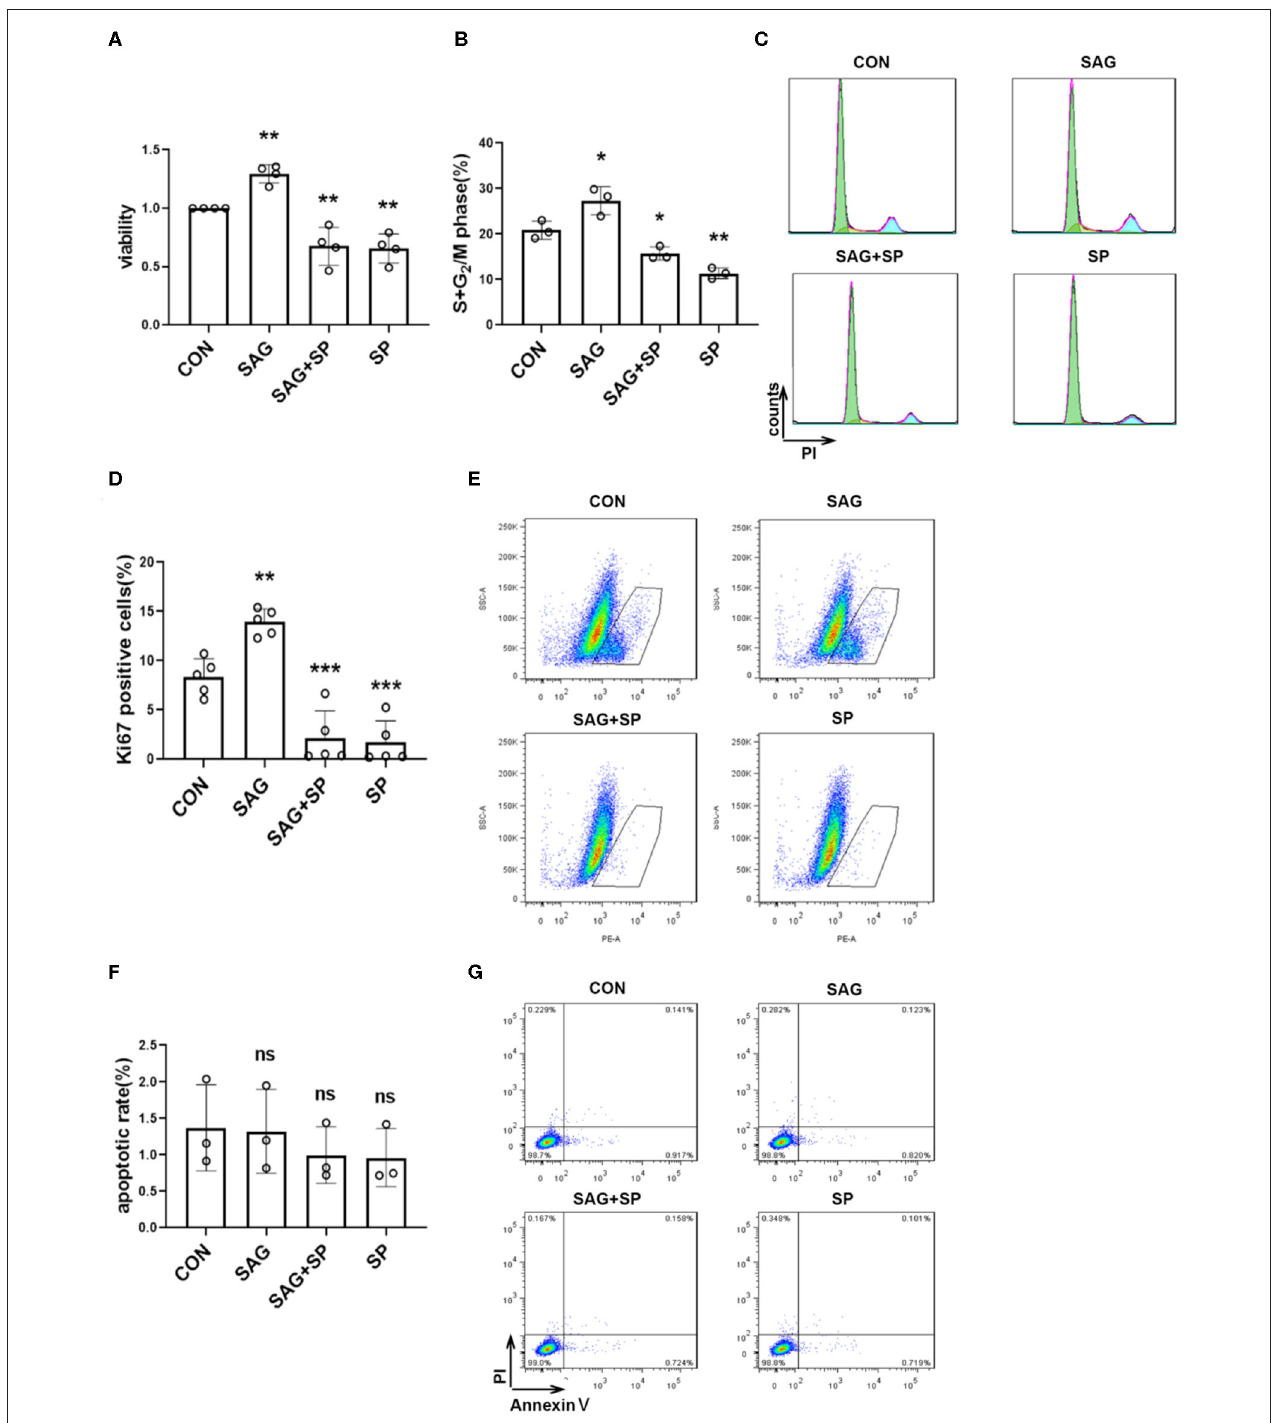
FIGURE 3 | SHH agonist promotes FLSs proliferation via JNK. (A) FLSs viability was assessed by Cell Counting Kit-8 assay after FLSs were treated with SHH agonist (SAG, 1 µ M) alone or SAG with JNK inhibitor (SP600125, 20 µ M) for 48h ( n = 4). (B–G) Cell cycle analysis, Ki-67 expression and cell apoptosis were assessed by flow cytometry. For the detection of cell cycle distribution (B,C) and expression of Ki-67 (D,E) , FLSs were treated with SAG (1 µ M) with or without SP600125 (20 µ M) for 18h. For the detection of cell apoptosis (F,G) , FLSs were treated with SAG (1 µ M) with or without SP600125 (20 µ M) for 24h. Percentage of apoptosis was defined by the number of AnnexinV + PI − cells. FLSs in control group were treated with vehicle (DMSO supplemented in DMEM with 10%FBS). The results are shown as the mean ± S.D. Data were analyzed using ANOVA and post hoc comparisons were made by Dunnett’s test (A,B,D,F) . * P < 0.05 vs. control group. ** P < 0.01 vs. control group. *** P < 0.001 vs. control group. ns, non-significant; CON, control group; SP, SP600125.